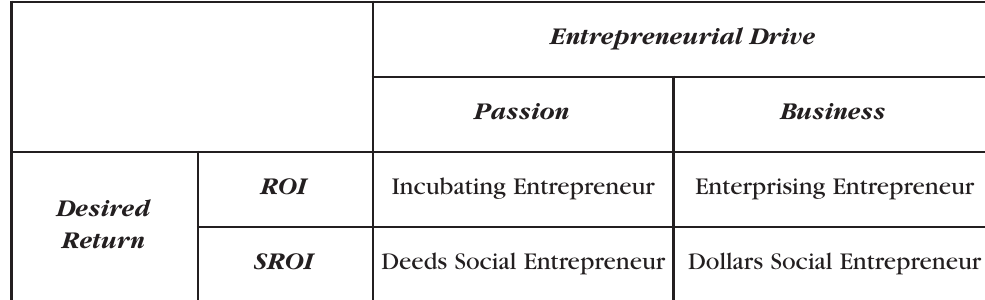
Table 1. An Enterprise Typology of